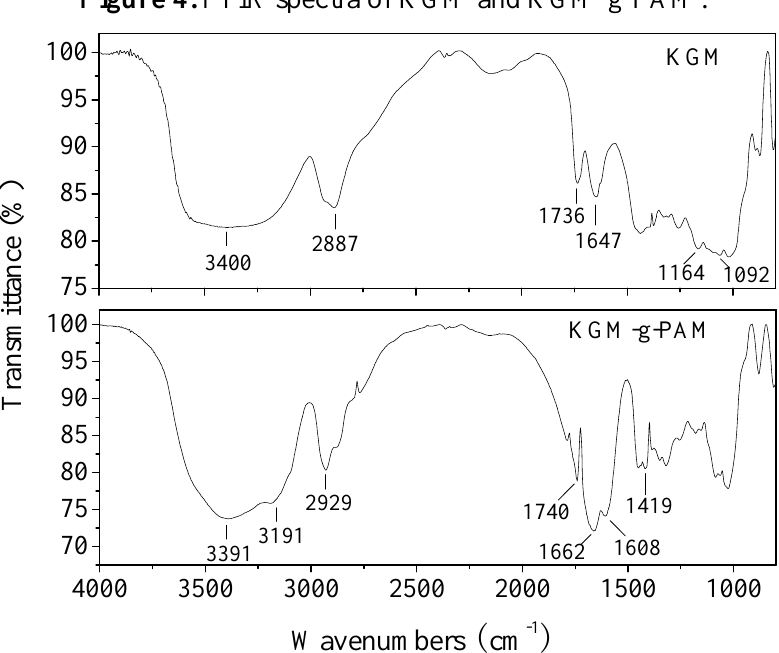
Figure 4. FTIR spectra of KGM and